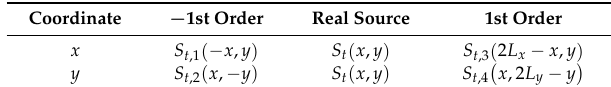
Table 1. Suppose a real sound source is located at S t ( x , y ) : its first-order image sound sources are (cid:0) (cid:1) x t , k , y t , k located at S t , k for different k at any time t . The corresponding coordinates and reflection orders are shown